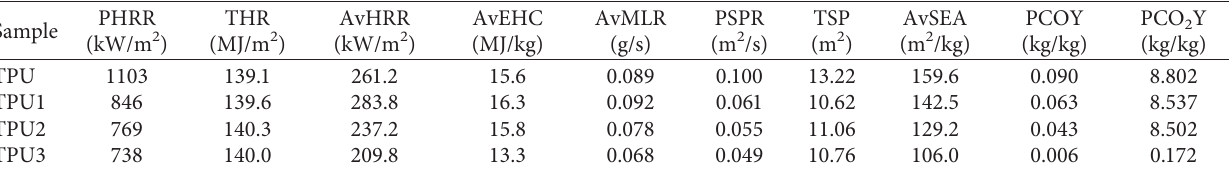
Table 2: Cone calorimeter data of TPU and TPU composites.